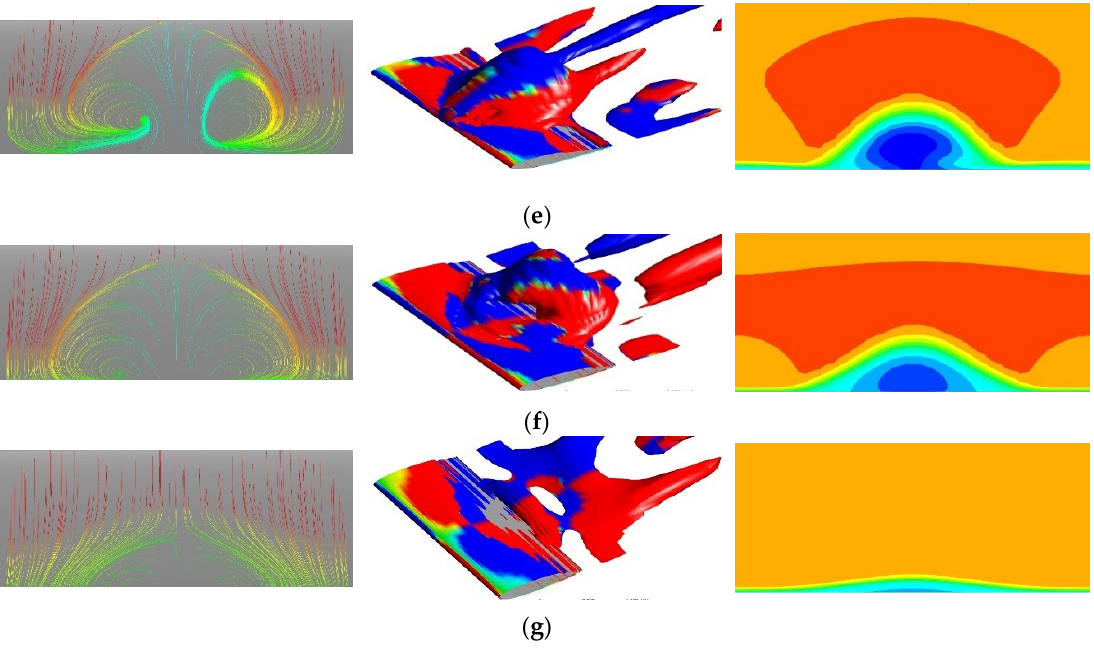
Figure 16. 3D flow structures on and above the aerofoil surface. f = 0.01, maximum AoA = 24°. ( a ) AoA = 19.26° ↓ ; ( b ) AoA = 18.45° ↓ ; ( c ) AoA = 16.69° ↓ ; ( d ) AoA = 15.75° ↓ ; ( e ) AoA = 14.78° ↓ ; ( f ) AoA = 12.76° ↓ ; ( g ) AoA = 11.72° ↓ .